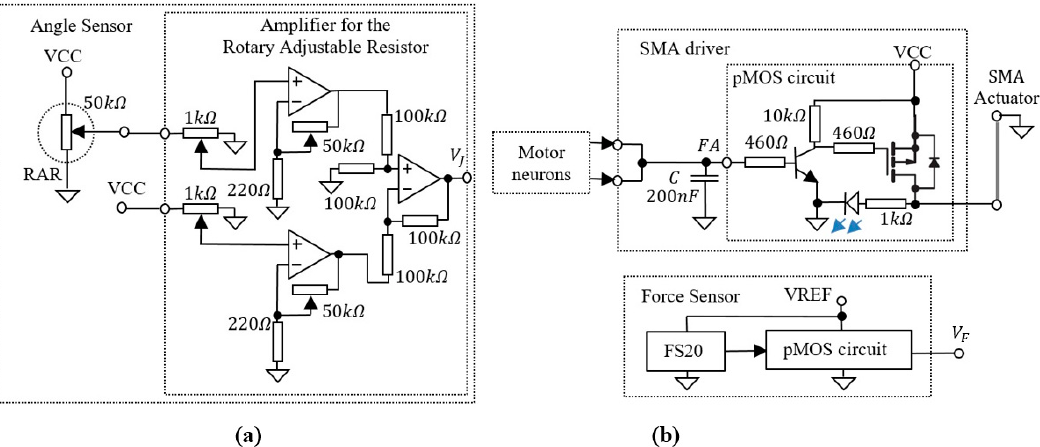
Figure 3. ( a ) Angle sensor including the rotary adjustable resistor and an amplifier; ( b ) SMA driver that integrates the spiking activity of the motor neurons and drives the SMA actuators; A similar pMOS circuit is used to amplify the output of a low force compression load cell FS20.